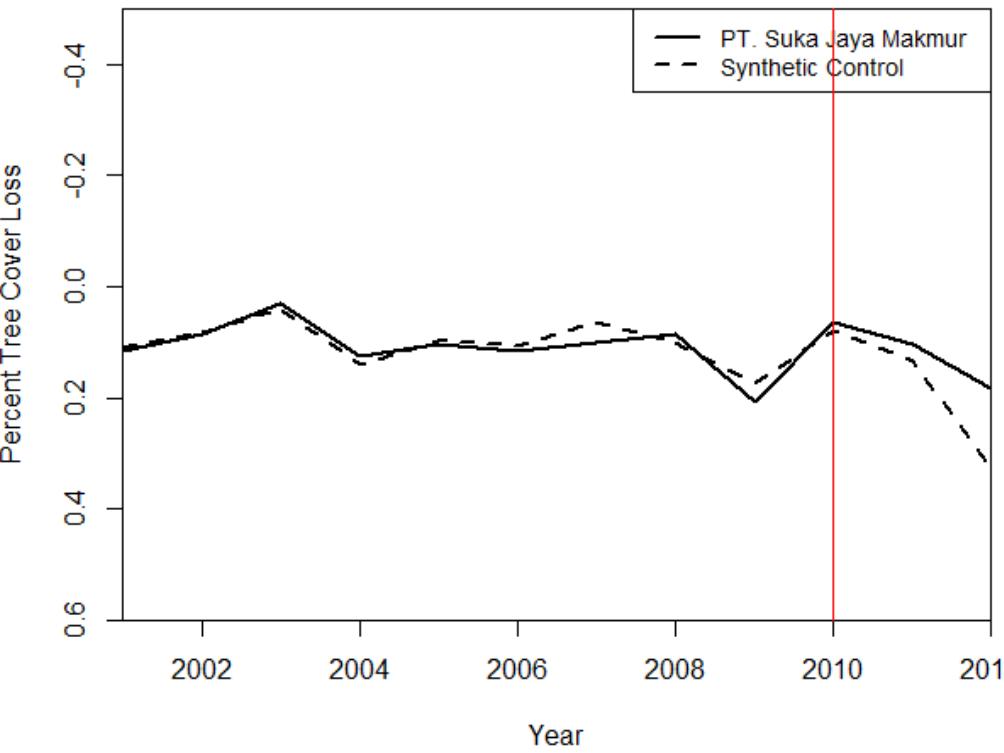
Figure 4. Comparison of tree cover loss in Suka Jaya Makmur and its synthetic control, 2001–2012. Tree cover loss increases down the y -axis. Red line indicates the year of certification.